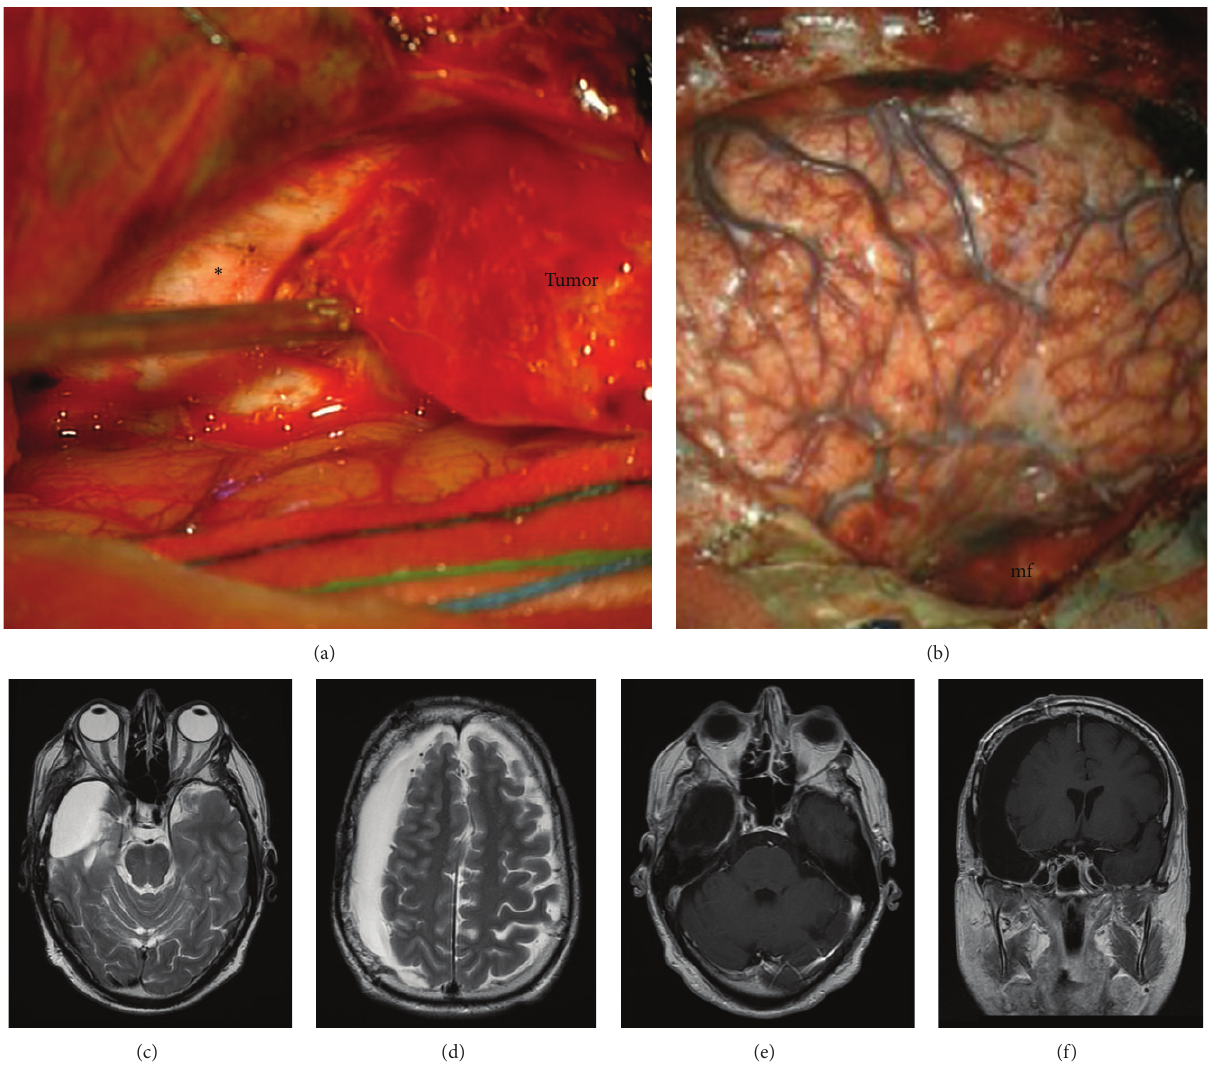
Figure 3: Intraoperative findings and postoperative results. (a) Intraoperative image showing subdural extra-leptomeningeal tumor. Asterisk indicates anterior fossa dura; mf: middle fossa. (b) Intraoperative image revealing complete resection. T 2 -weighted ((c) and (d)) and gadolinium enhanced T 1 -weighted ((e) and (f)) images showing no evidence of sarcoma recurrence at 3